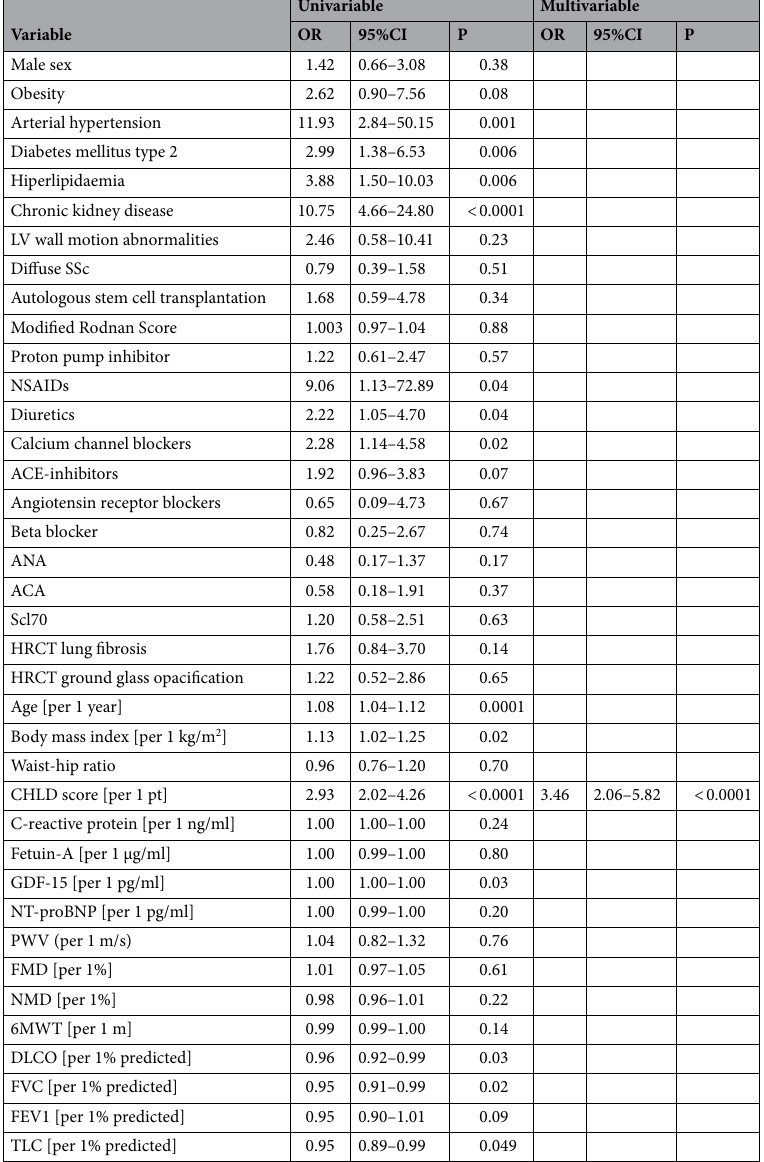
Table 2. Univariable and multivariable cox proportional hazards analysis. 6MWT: 6-min walk test; ACE: angiotensin-converting enzyme; ANA: antinuclear antibodies; ACA: anticentromere antibodies;